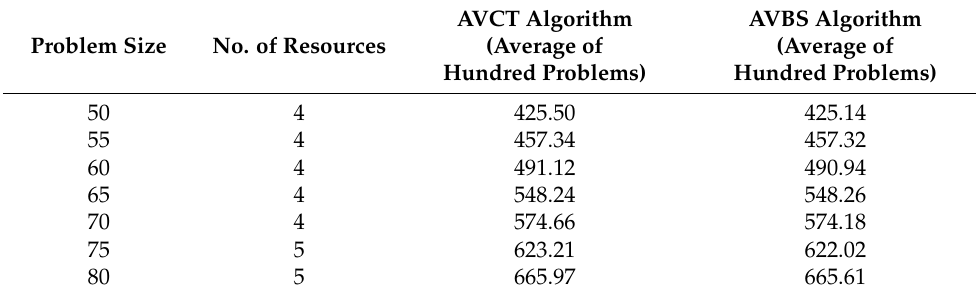
Table 4. Comparison of AVCT and AVBS